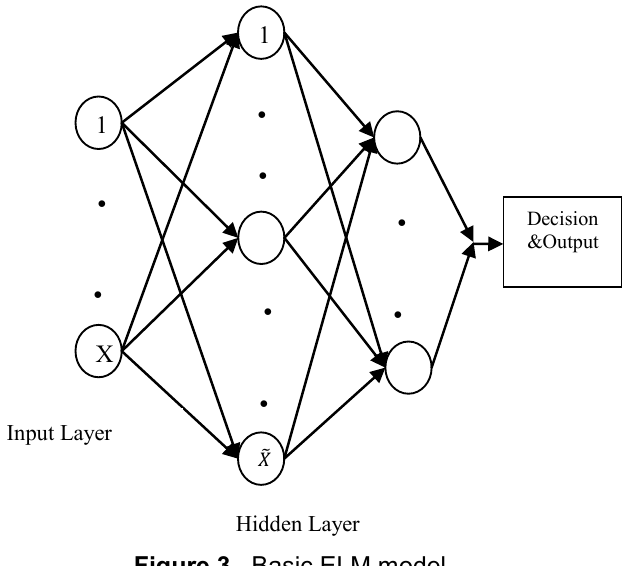
Figure 3 . Basic ELM